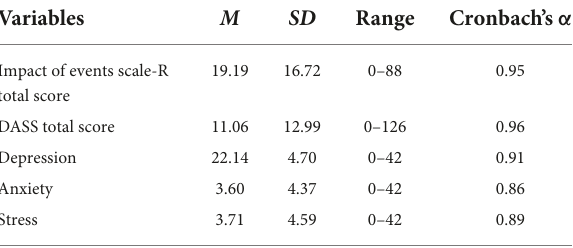
TABLE 2 Psychometric properties for Impact of Events Scale-Revised and DASS (Depression, Anxiety, and Stress Subscales) ( N =